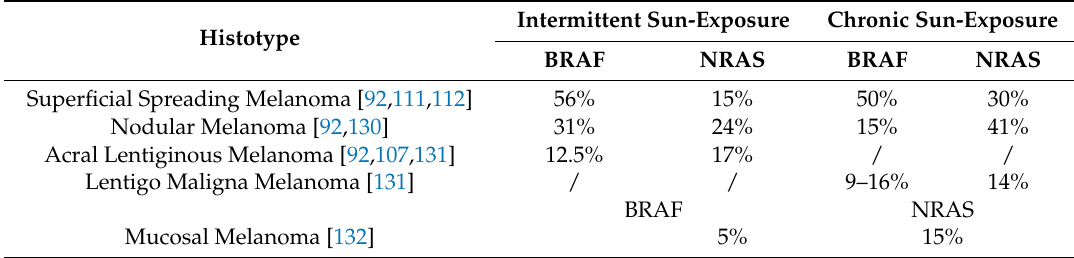
Table 1. Percentage of BRAF and RAS mutant melanomas according to histological type and sun